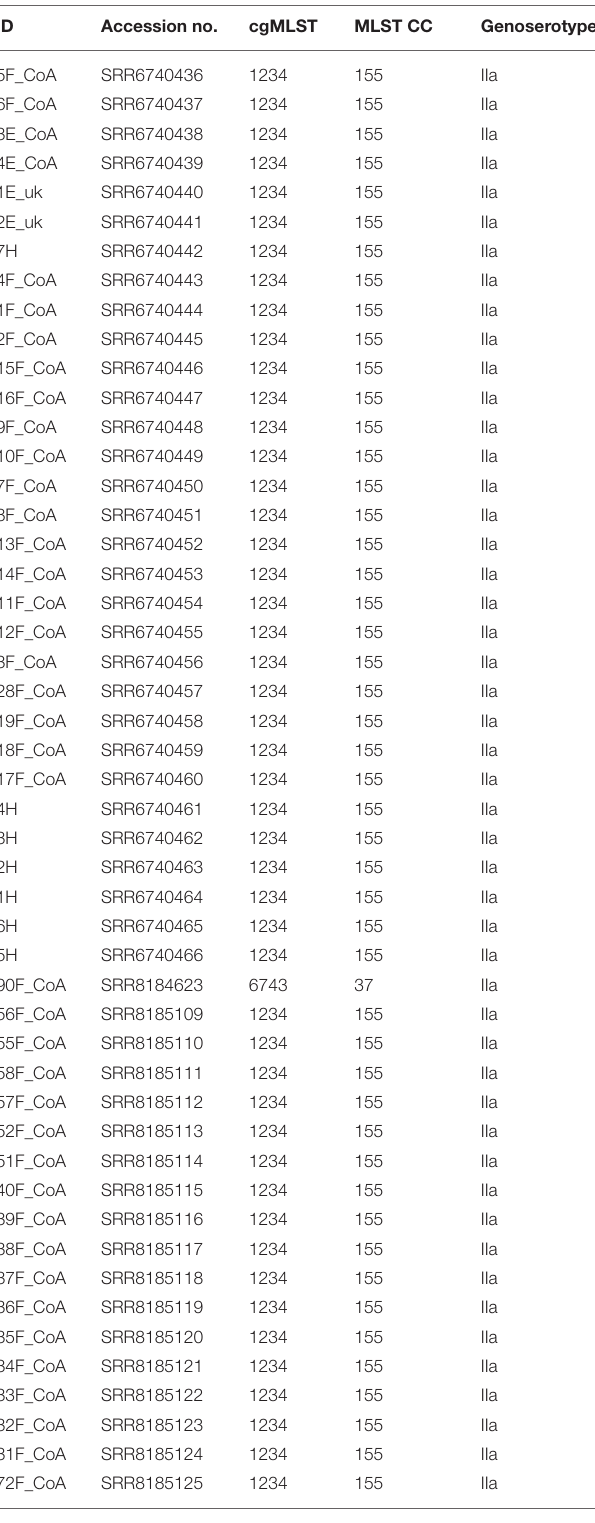
TABLE 1 | Accession numbers of sequences available at NCBI Sequence Read Archive